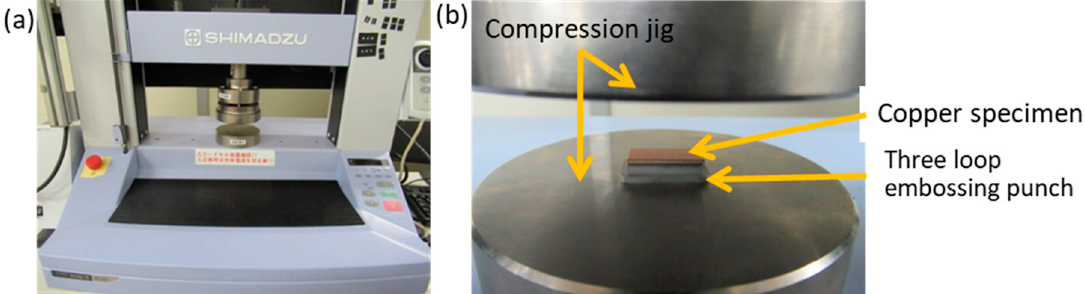
Figure 6. Micro-embossing in the uniaxial compression onto the copper plates. ( a ) Overview of the compression testing machine and ( b ) enlarged view of the micro-embossing experiment condition.